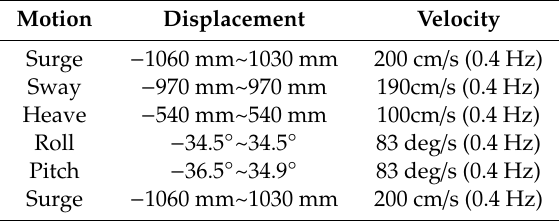
Table 2. Range of Displacement and Velocity.